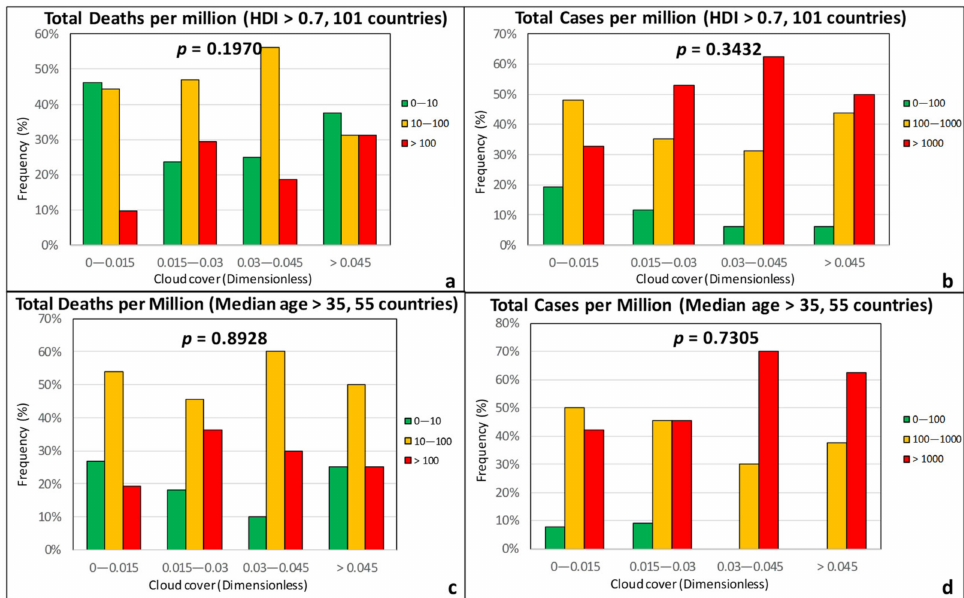
Figure 8. Frequency of total deaths per million (green: low, 0–10; orange: moderate, 10–100; red: high, > 100) and total cases per million (green: low, 0–100; orange: moderate, 100–1000; red: high, > 1000) as a function of the cloud cover for countries with an HDI over 0.7 ( a , b ) and a median age over 35 years ( c , d